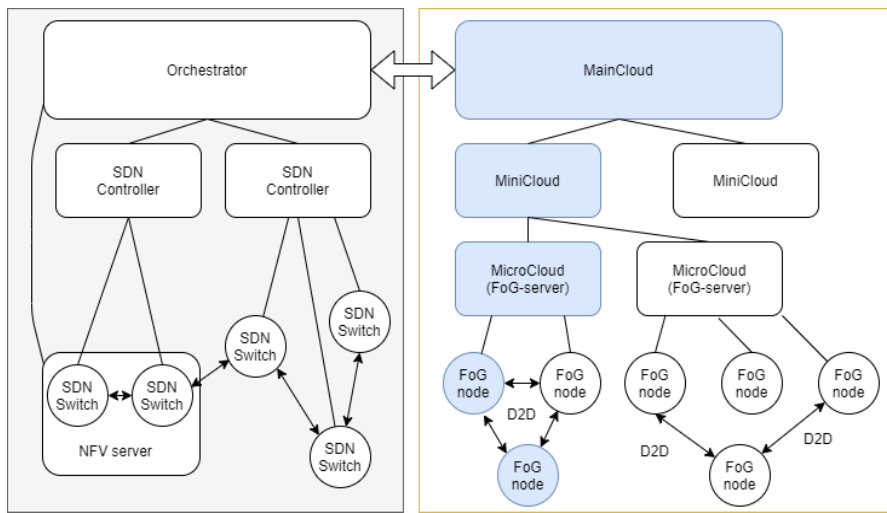
Figure 4. Functional diagram of the elements.